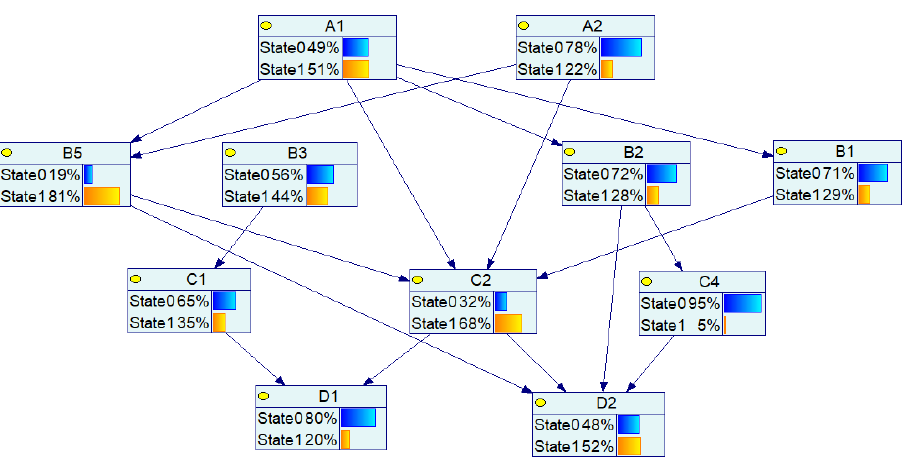
Figure 6. BN model.